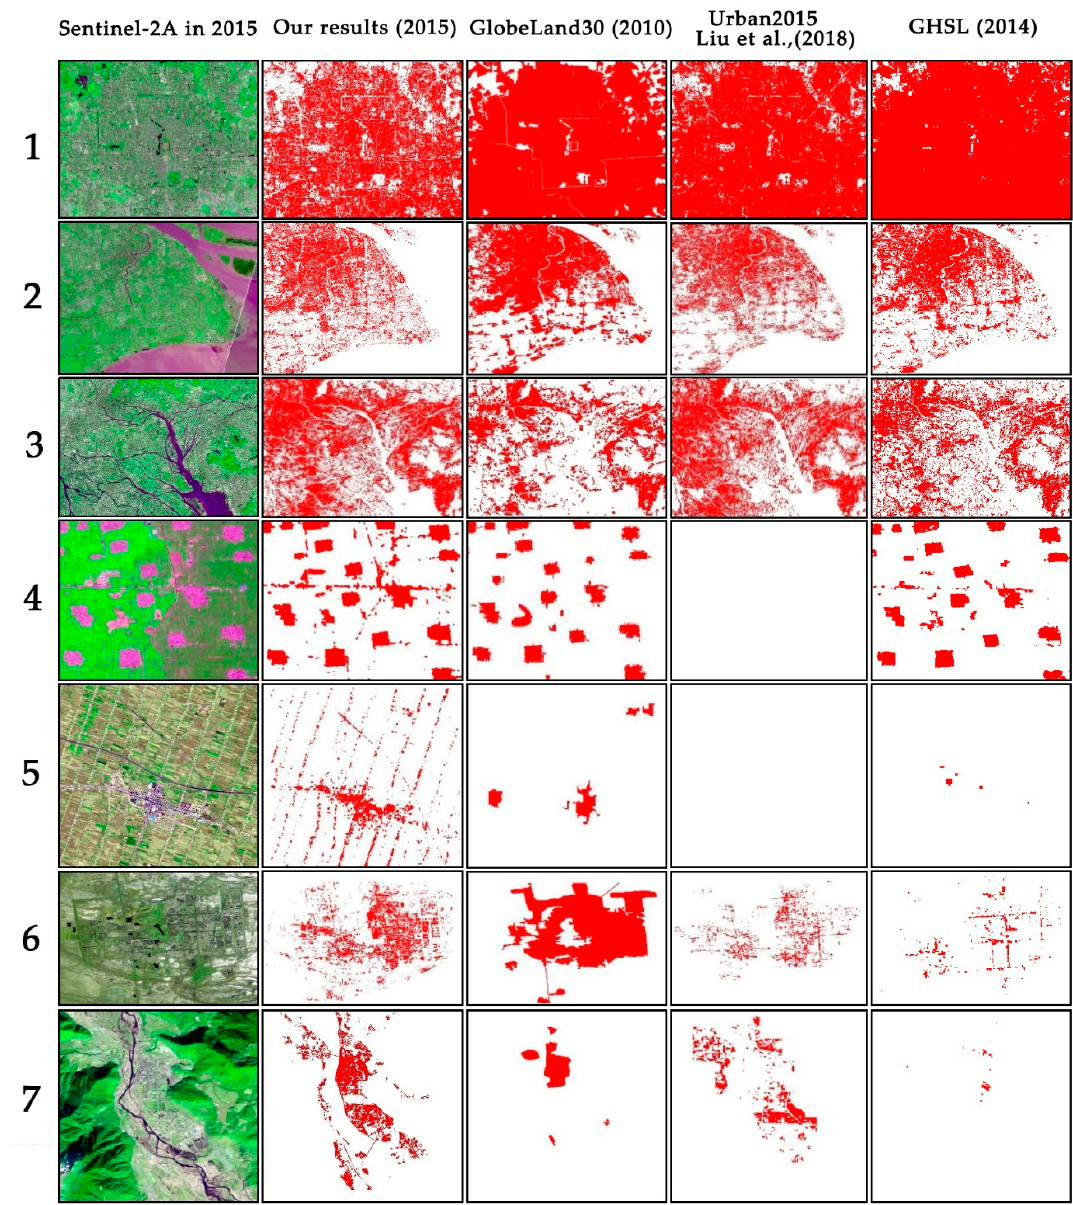
Figure 15. Comparing the urban land classifications obtained by our method and other products.